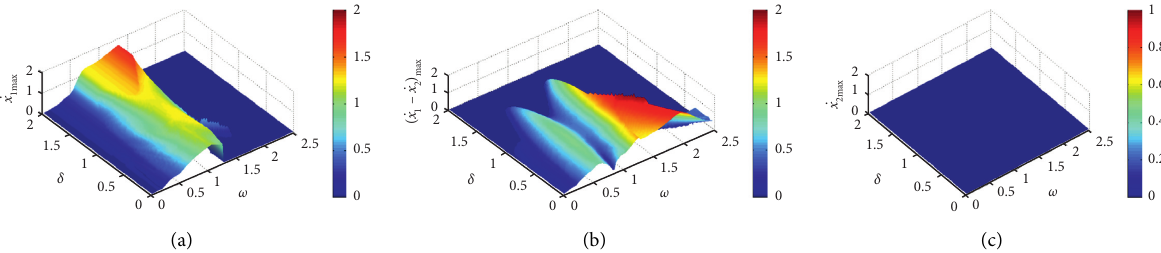
Figure 24: Local enlargement of Figure 23(b).